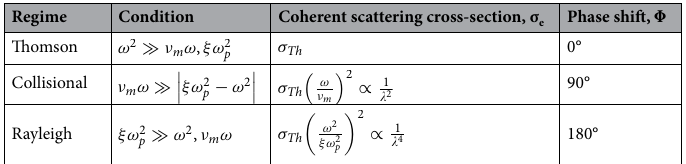
Table 1. Coherent microwave scattering regimes.